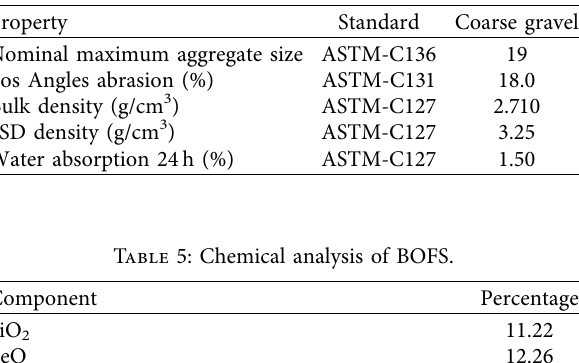
Table 4: Technical specifcation of slag.